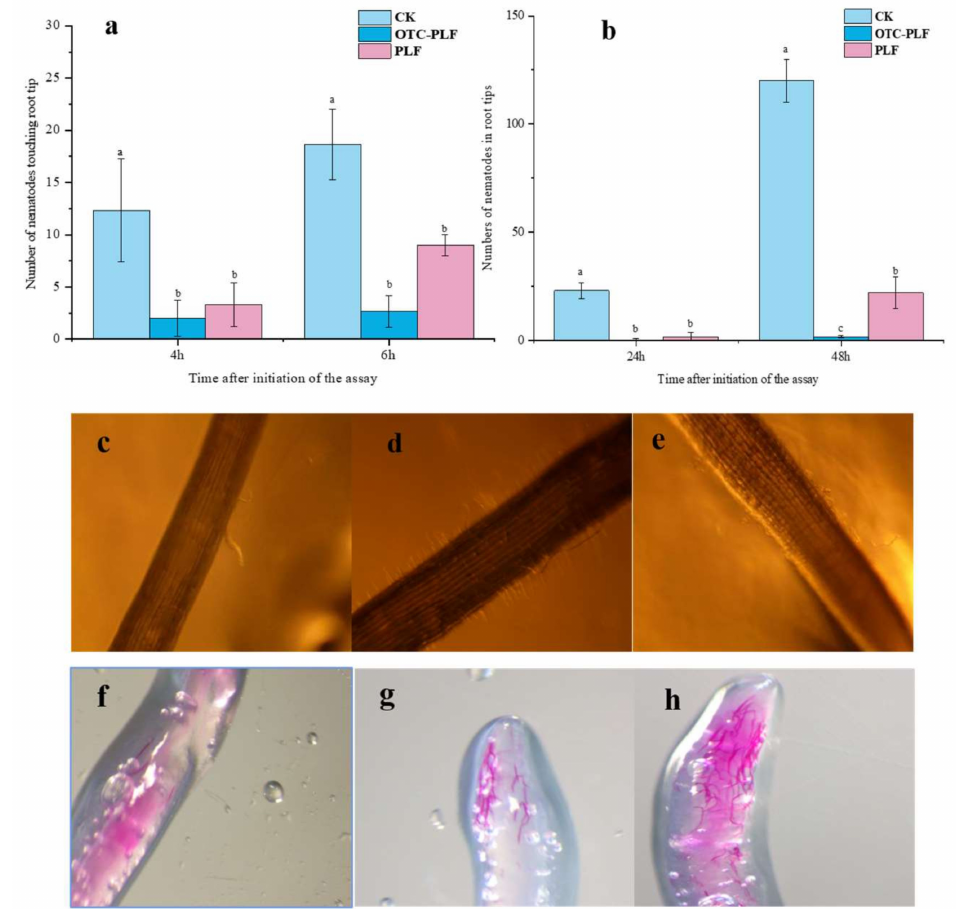
Figure 7. Effect of culture filtrates (OTC-PLF and PLF) on the invasion of M. incognita J2s towards cucumber in Pluronic gel. ( a ) was the number of J2s around the root at 4 h and 6 h. ( b ) was the number of J2s in the root at 24 h and 48 h. ( c – e ) were the movement of M. incognita J2s towards the tomato root tip in Pluronic gel. ( f – h ) were the localization of J2s inside roots 48 h post infection. ( c , f ) “were treated by OTC-PLF. ( d , g ) were treated by PLF. ( e , h ) were blank controls. OTC-PLF represents the culture filtrates of Purpureocillium lilacinum combined with by 6-oxychitin. PLF represents the culture filtrates of Purpureocillium lilacinum . CK represents the blank control. Different letters represent significant differences ( p < 0.05) according to Duncan’s